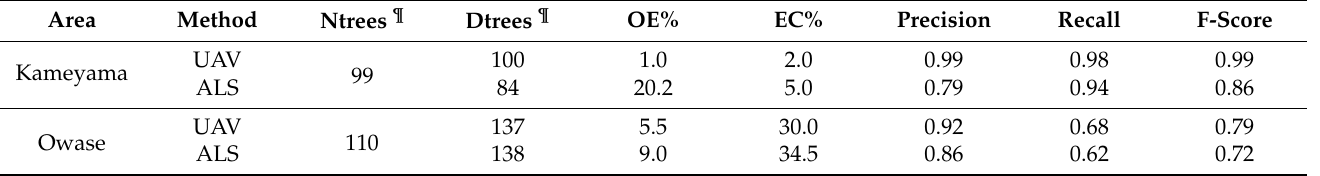
Figure 6. An illustration of point-cloud coincidence of UAV-SfM RPC referencing transformation via bi-temporal ALS point cloud data. The images on the left and center ( a – i ) show a flowchart-based subfigure of the data flow and output of the processing. The images on the right ( j , k ) depict the histogram of ALS and UAV-SfM data approximation. ( b ) is the UAV-SfM RPC acquired in 2019 and ( a , c ) are the referencing ALS point cloud data acquired in 2013 and 2020, respectively. ( d ) is the registered ICPPC data based on ALS2013. It shows the enlarged map of the box in the source image ( a , b ). ( e , h ) are the 2nd further enlarged maps of the box and the transect line in ( d ), respectively. Correspondingly, ( g ) is the ALS2020-registered ICPPC data. It displays the 1st enlarged map of the box in the source image ( b , c ). ( f , i ) are the 2nd further enlarged maps of the box and the transect line in ( g ), respectively. A collection of tree crowns is highlighted and visible from ICPPC2013 and ICPPC2020 and their enlarged maps. Changes in canopy surface from 2013 to 2020 over the profile of transect line, derived via the ALS data and UAV-SfM data, are viewable in ( h , i ). The changes presented by both the ALS and the UAV-SfM data in ( j ) are similar, ranging from − 1 to +2 m and behaving as a Gaussian distribution. In ( k ), the ICPPC is laid on the ALS point cloud data based on the acquisition year. As can be seen, the alignment of both projected ICPPC2013-ALS2013 and ICPPC2020-ALS2020 show the acceptable results of the proposed method. Table 4. Evaluation of the number of trees based on the image-interpretation-based manual delin- eation method and the PyCrown technique-based automatic delineation